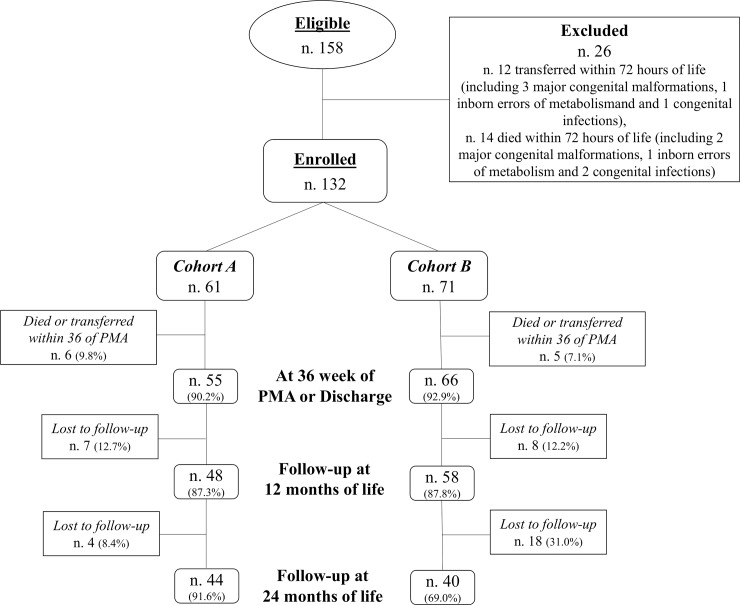
PMA: Postmenstrual age.